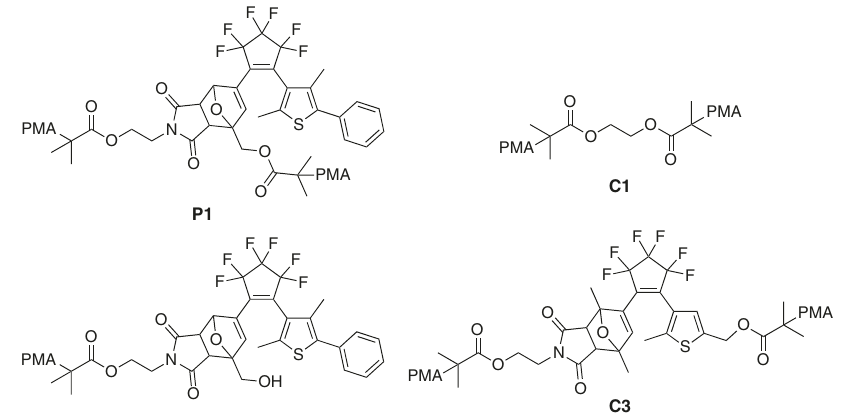
Fig. 3 Chemical diagrams. Polymer structures used in this